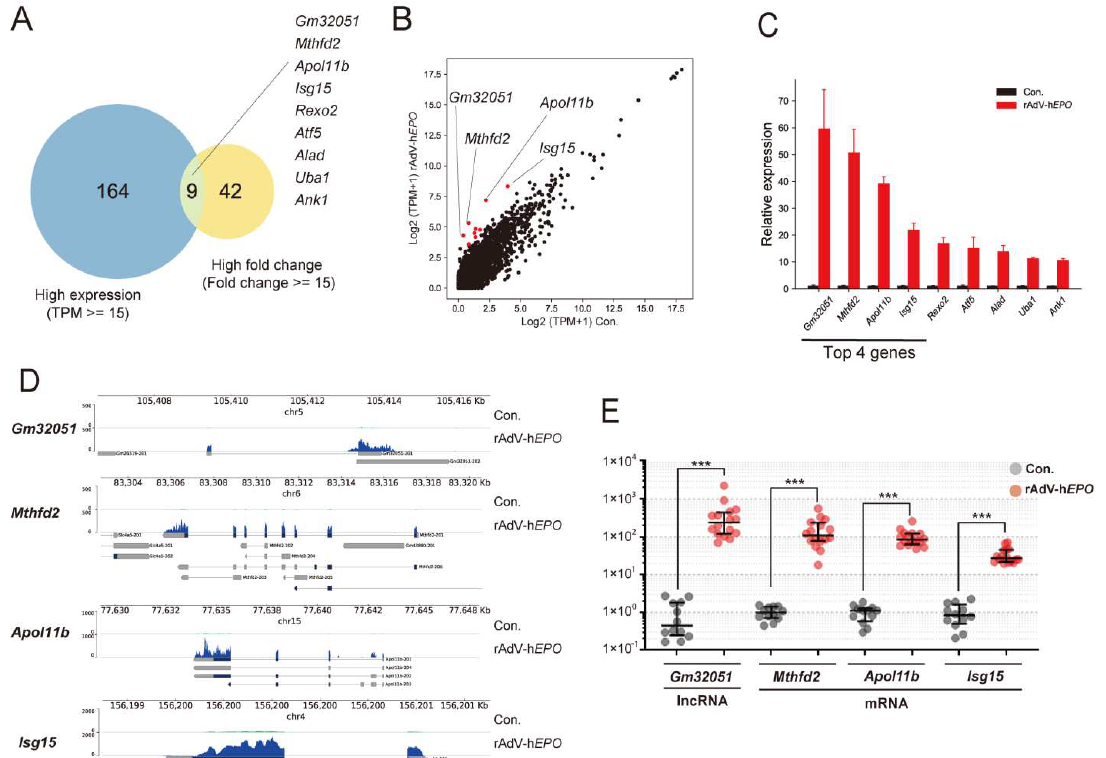
Figure 4. Single RNAs identified as indirect proof by bioinformatics screening. ( A ) Venn diagram showing the number of DEGs with filtering for high expression and high fold expression. ( B ) Scatter plot showing nine overlapping genes with filtering. ( C ) Relative gene expressions (Con. = 1.0) showing nine overlapping genes. ( D ) Genome browser indicating the read mapping results of the top four genes. ( E ) Confirmation of the top four genes as indirect proof by using the TB Green qPCR assay. *** p < 0.001.